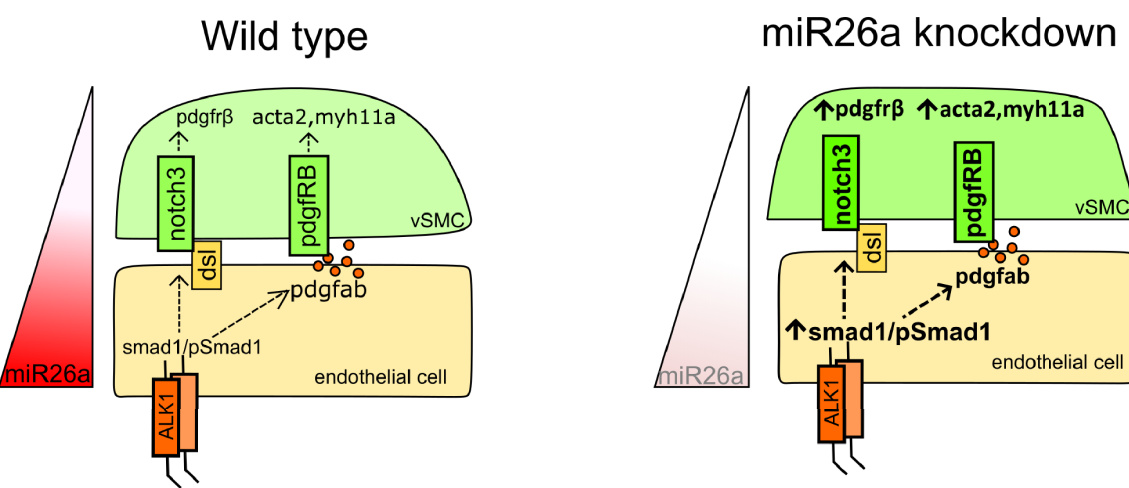
Fig 8. Mechanistic model by which miR26a modulates BMP signaling to promote vSMC differentiation via interactions with endothelial cells. miR26a modulates vascular stability by directly targeting smad1 . At developmental stages when smooth muscle appears, the endothelium has active BMP signaling. Loss of miR26a results in increased BMP signaling in endothelial cells where Smad1 becomes phosphorylated. Increased pSmad1 in endothelial cells leads to increased differentiation ( acta2 expression) and increased vSMC cell number, while blocking BMP signaling leads to a decrease of both. (Dashed arrows indicated the indirect effect on vSMC marker expression and cell number).